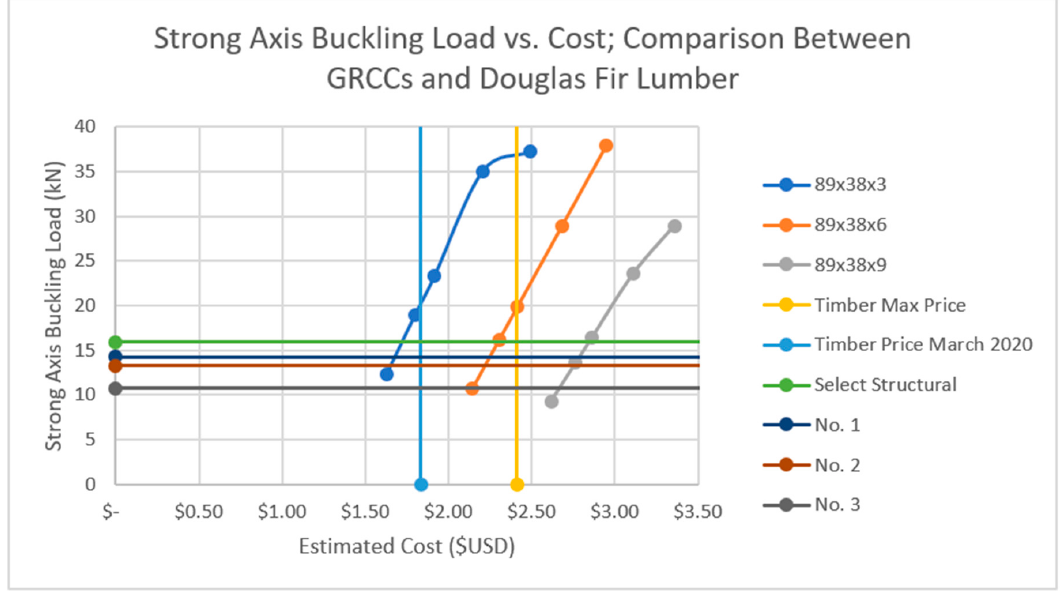
Figure 9. The cost vs. strong axis buckling load comparison for the various grades of Douglas fir and the GRCC equivalents.